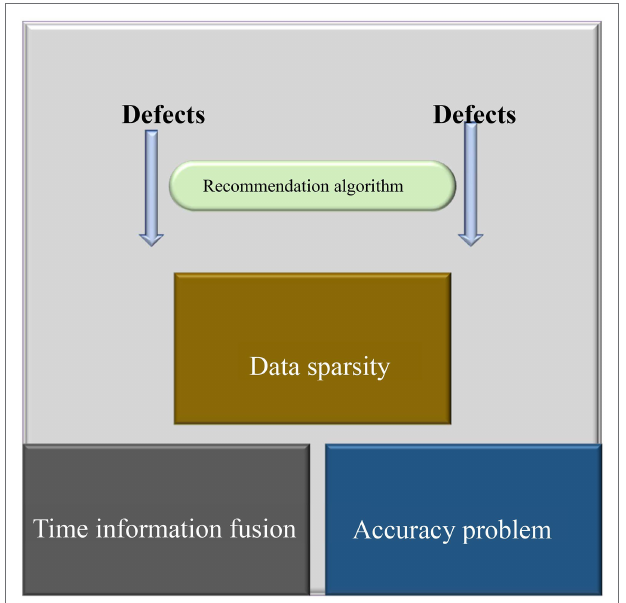
FIGURE 2 | Deficiencies of the existing course recommendation algorithm.